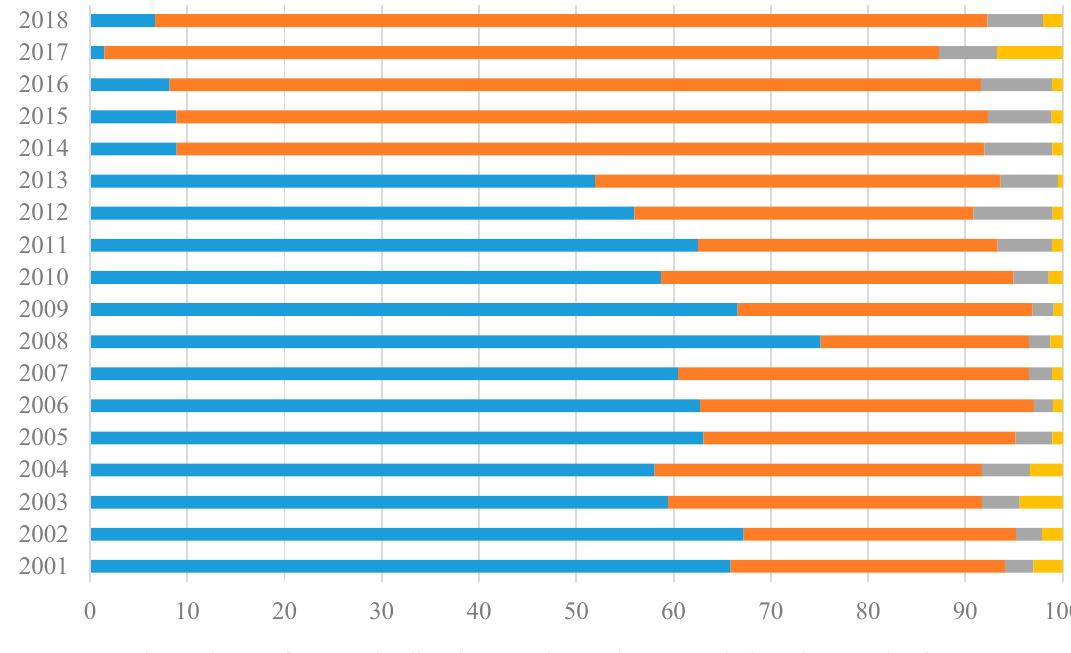
Bank deposits Other investments Figure 1. Structure of investment portfolio of OPFs in the Polish pension system, 2001–2018 (in %). Source: own study based on Komisja Nadzoru Finansowego, Publikacje i opracowania, Dane statystyczne, Rynek emerytalny, https://www.knf.gov.pl/publikacje_i_opracowania.